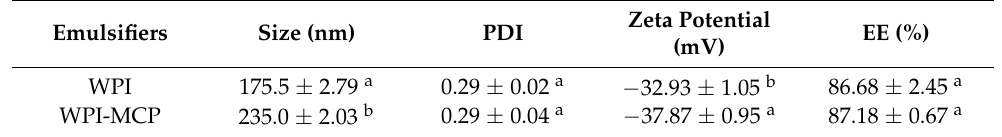
Table 2. The size, PDI, zeta potential and EE of β -carotene emulsions.